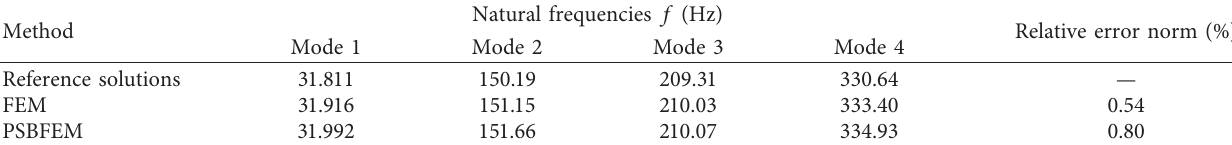
Table 2: The first four natural frequencies (Hz) of a multihole panel.